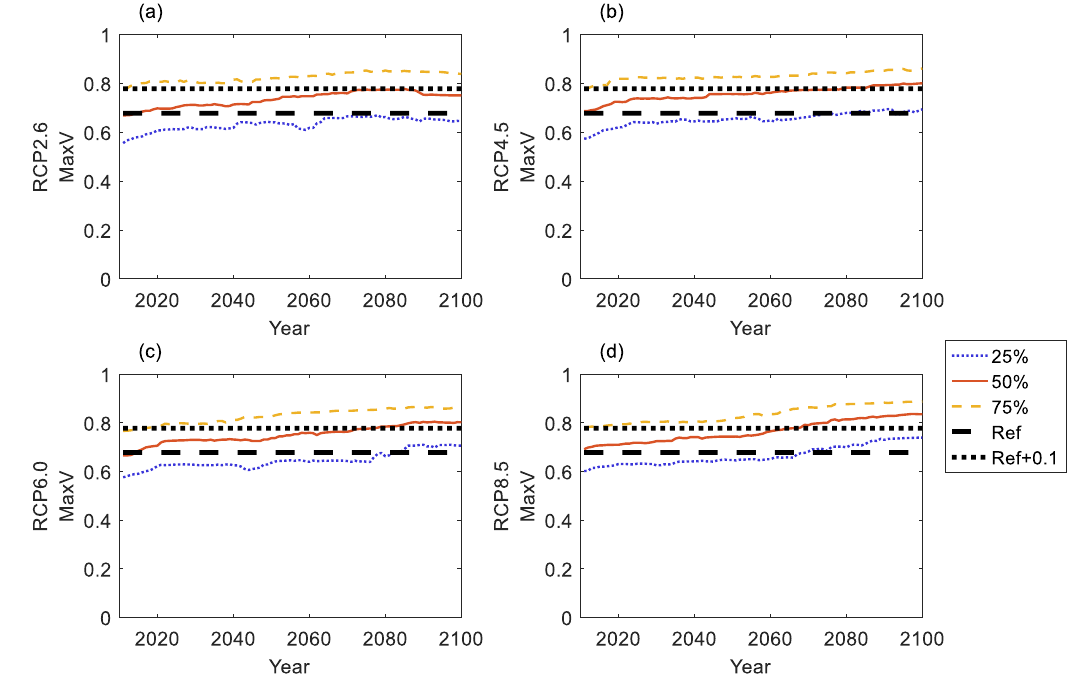
Figure 9. Maximum vulnerability under RCP 2.6 ( a ), 4.5 ( b ), 6.0 ( c ), and 8.5 ( d ) for a 40-year moving window, with the horizontal axis being the last year of the window. The thick dashed and dotted lines represent the reference historical performance and 10% worse-than-the-reference value, respectively.